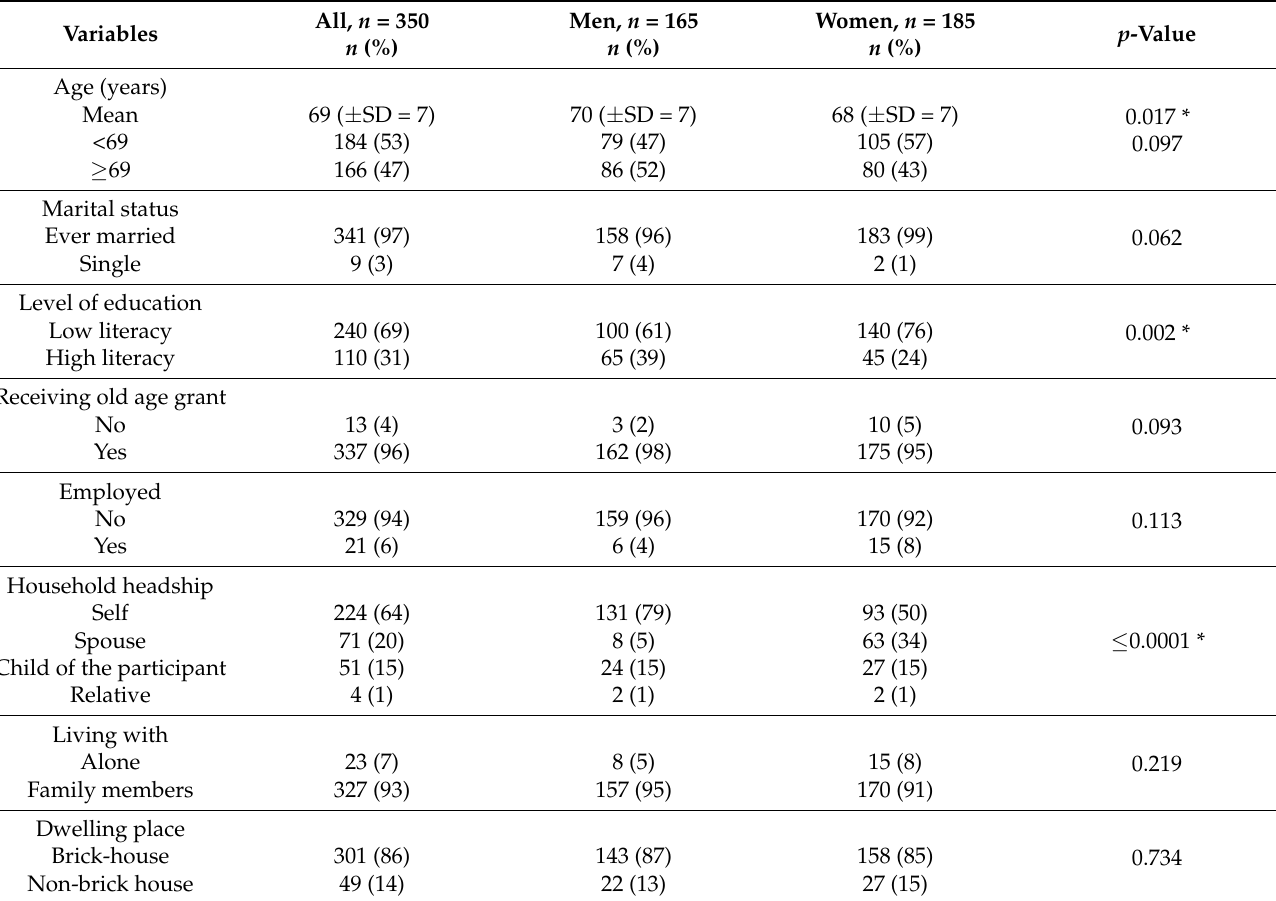
Table 1. Comparison of the characteristics of participants by